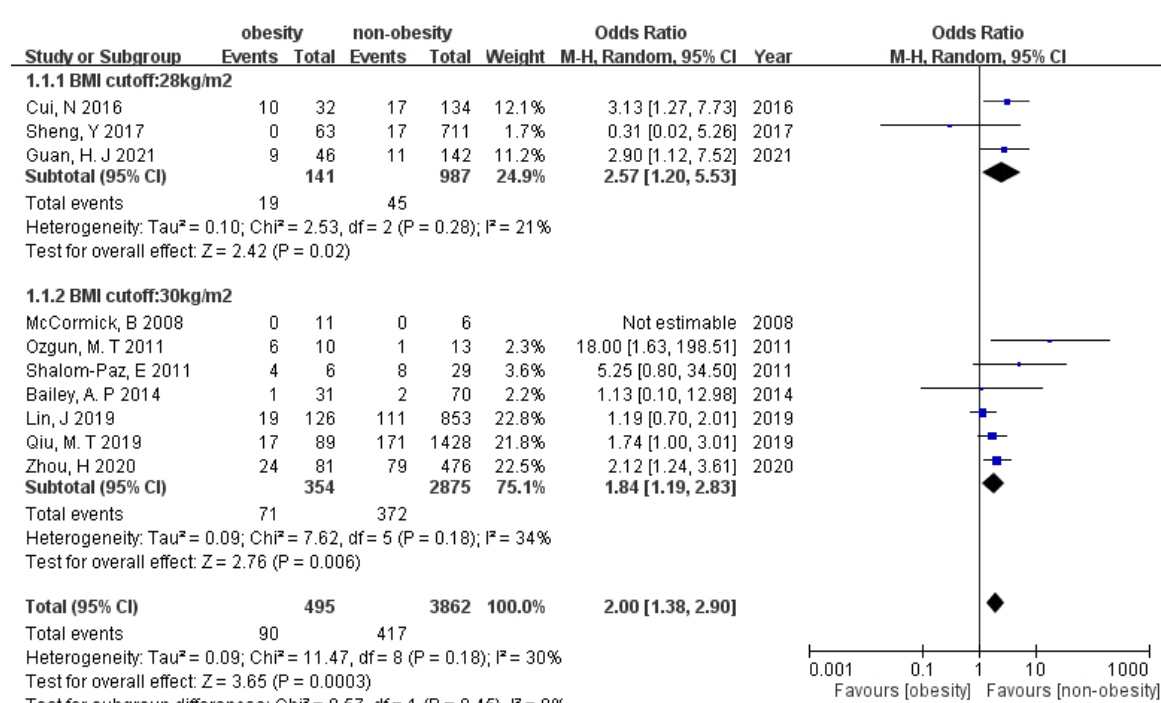
Figure 2. Forest plot of the association between miscarriage and overweightness in women with PCOS.